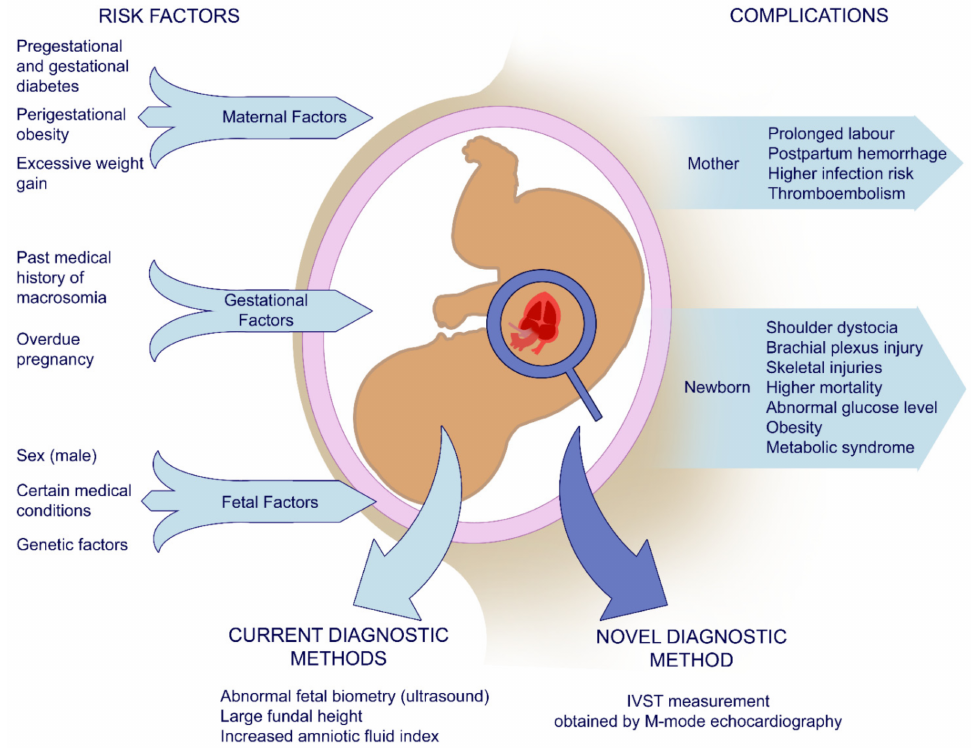
Figure 1. Schematic representation of maternal, gestational, and fetal risk factors of macrosomia and related complications and parameters used in the diagnostic process. IVST—interventricular septal